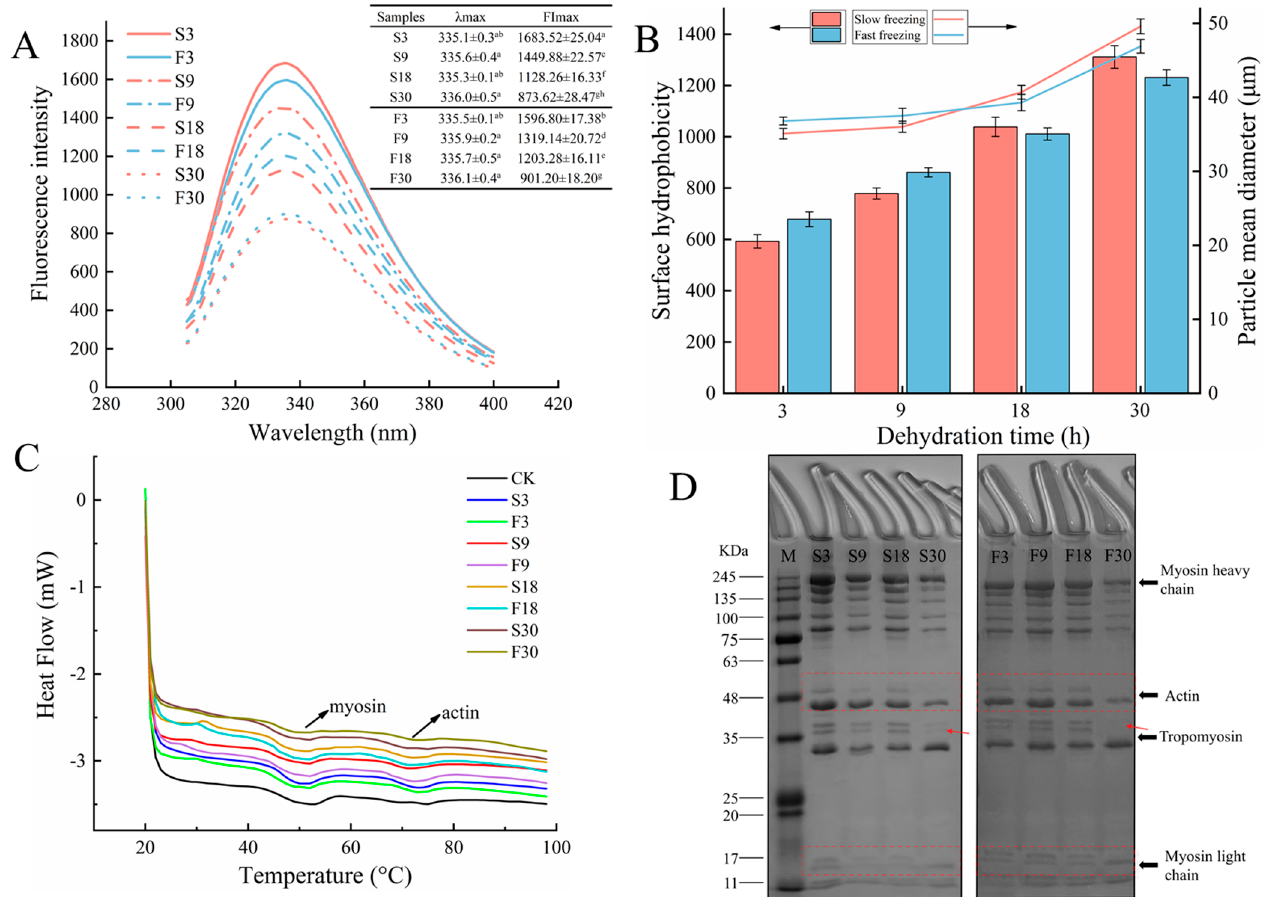
Figure 5. Effect of dehydration treatment on intrinsic fluorescence spectra ( A ), surface hydrophobicity and particle size ( B ), differential scanning calorimetry ( C ), and SDS-PAGE ( D ) of large yellow croakers. Different lowercase letters in the same index indicate significant differences ( p < 0.05).